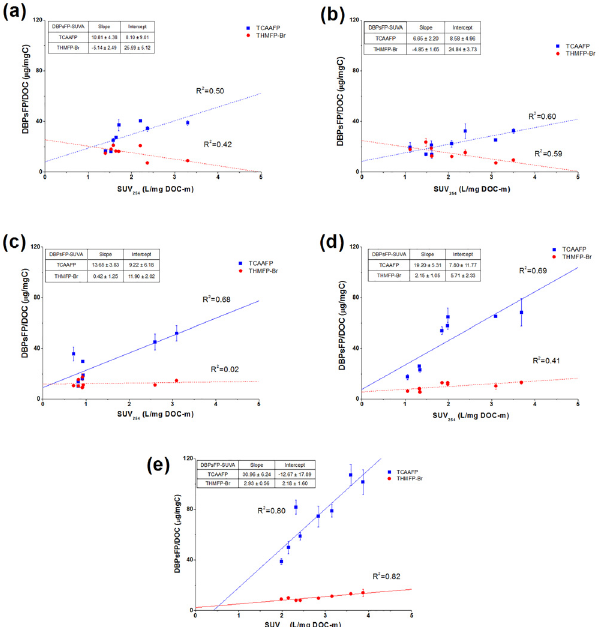
Fig 1. Correlations of TCAAFP and THMFP-Br yields with SUVA values in the raw and coagulated waters. (a) > 100k Da fraction; (b) 30-100k Da fraction; (c) 10-30k Da fraction; (d) 3-10k Da fraction; (c) < 3k Da fraction.